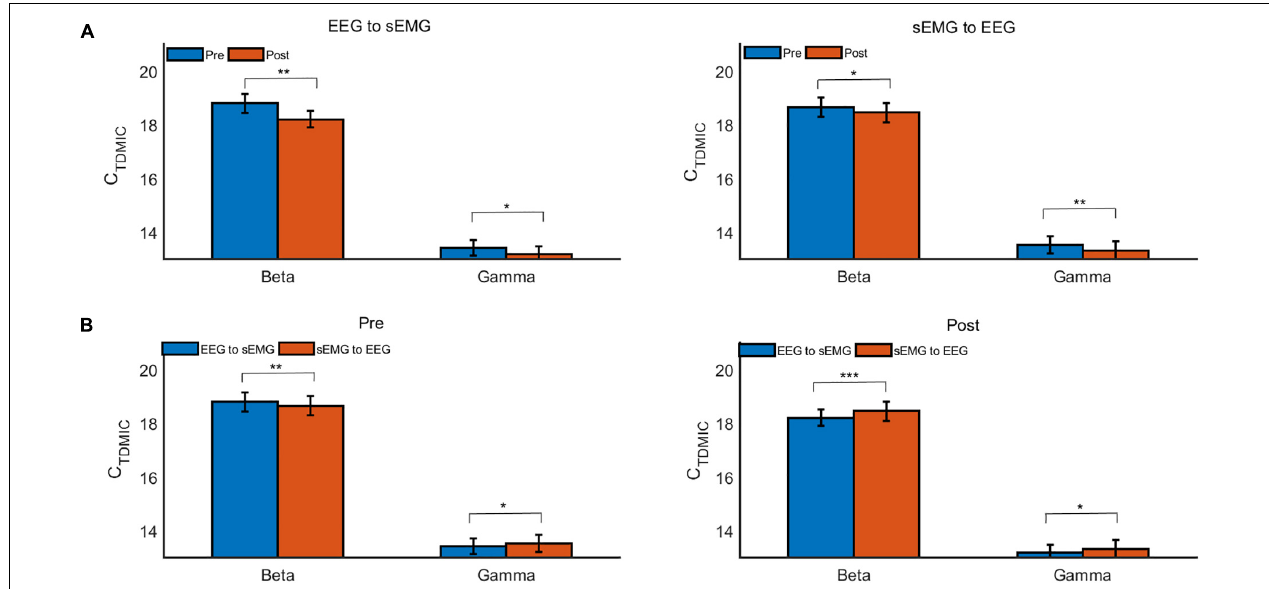
FIGURE 9 | The grand average C TDMIC values under different conditions. (A) Comparison of the C TDMIC values between pre- and post-fatigue tasks under different conditions. (B) Comparison of the C TDMIC values between the EEG to sEMG and the sEMG to EEG directions under different conditions. * p < 0.05, ** p <